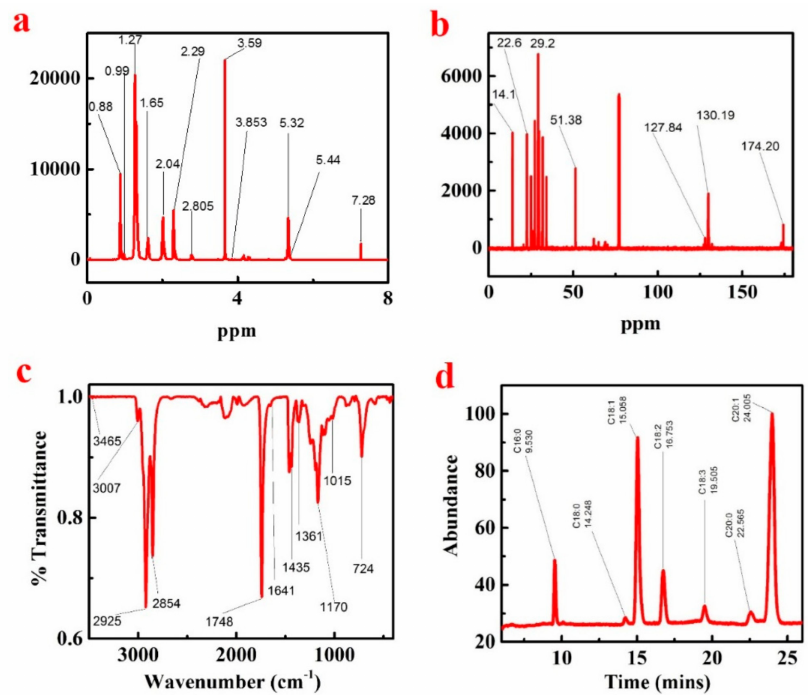
Figure 4. 1 H NMR ( a ), and 13 C NMR ( b ), KP (methyl ester) FTIR study ( c ), KP seed oil biodiesel GC–MS fatty acid compositions analysis ( d